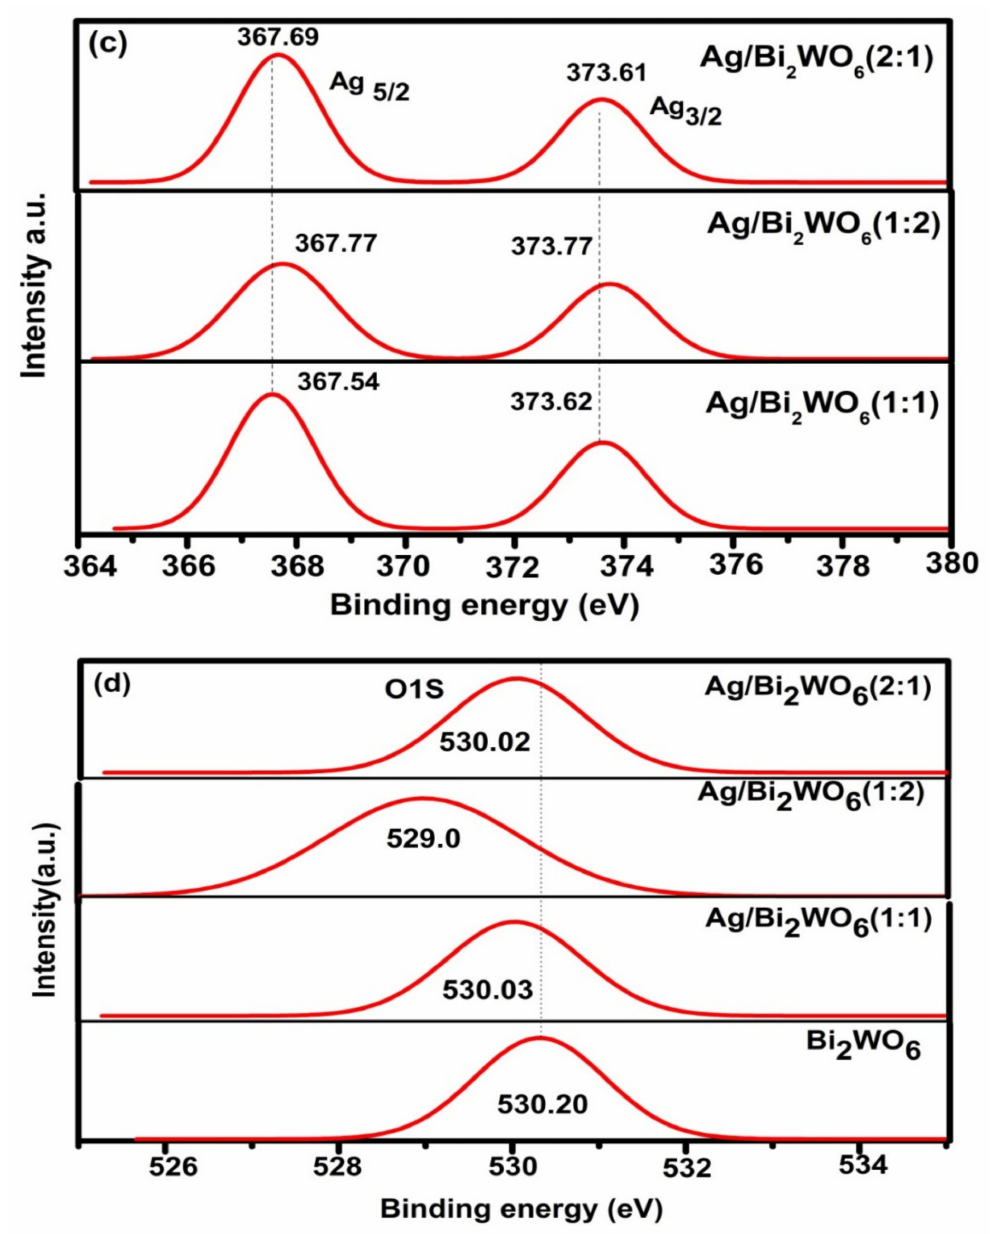
Figure 9. XPS spectra: ( a ) Bi4f peaks, ( b ) W4f peaks, ( c ) Ag3d peaks and ( d ) O1S peaks. Table 2. Summary of BET result of pure Bi 2 WO 6 and Ag/Bi 2 WO 6 (1:1, 1:2 and 2:1).